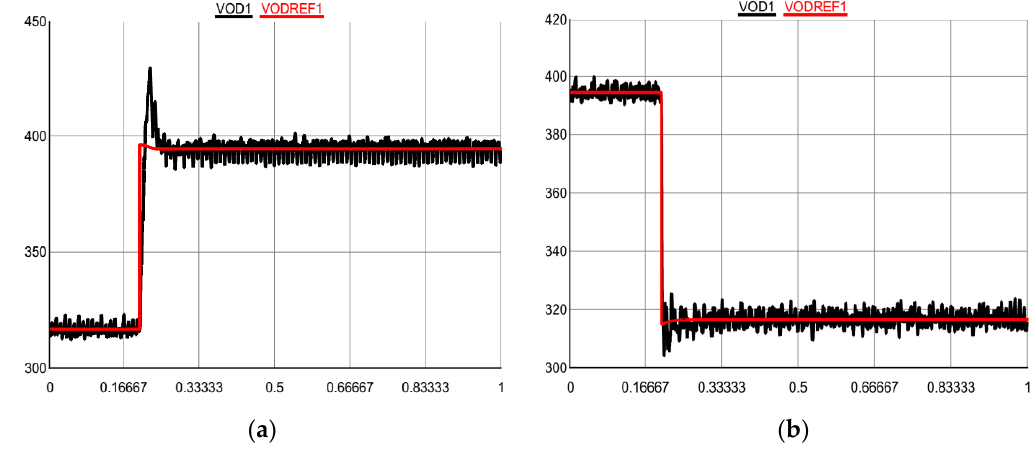
Figure 13. ( a ) DG1 output voltage and ( b ) DG1 reference voltage due to voltage step changes.